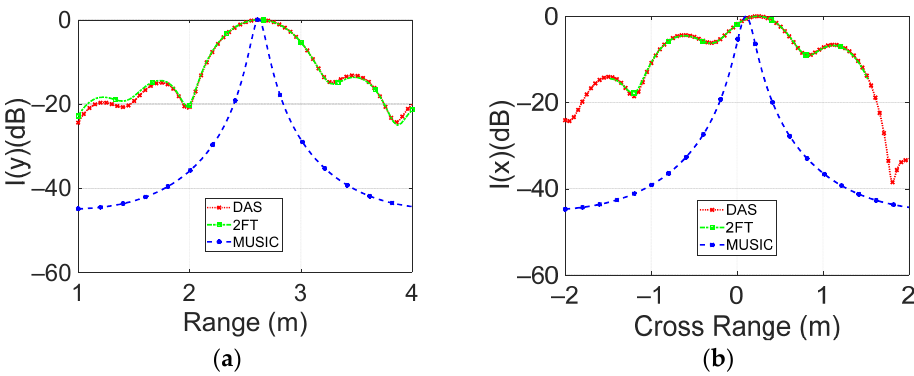
Figure 18. The normalized intensity function versus ( a ) range and ( b ) cross-range distance is reported. Panel distance is 2.6 m away from the radar antenna.